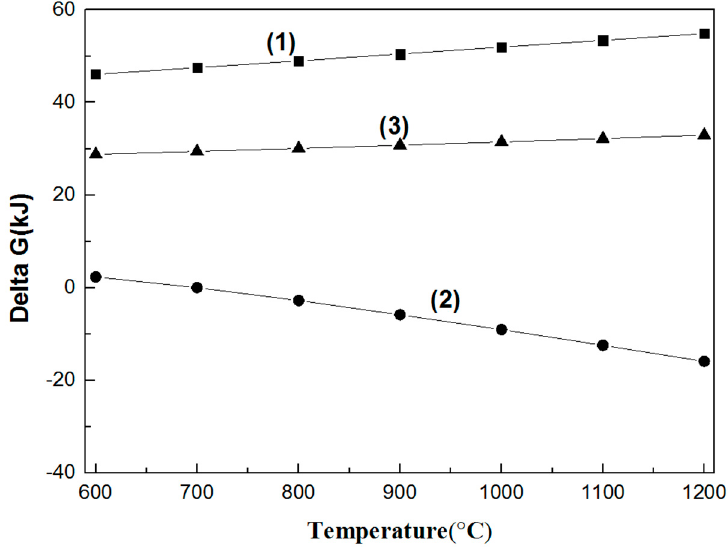
Figure 4. Gibbs free energy of the decomposition reaction of the three spinels in the 600–1200 °C temperature range. (1) MgO · Cr 2 O 3 = MgO + Cr 2 O 3 ; (2) MgO · Fe 2 O 3 = MgO + Fe 2 O 3 ; (3) MgO · Al 2 O 3 = MgO + Al 2 O 3 .